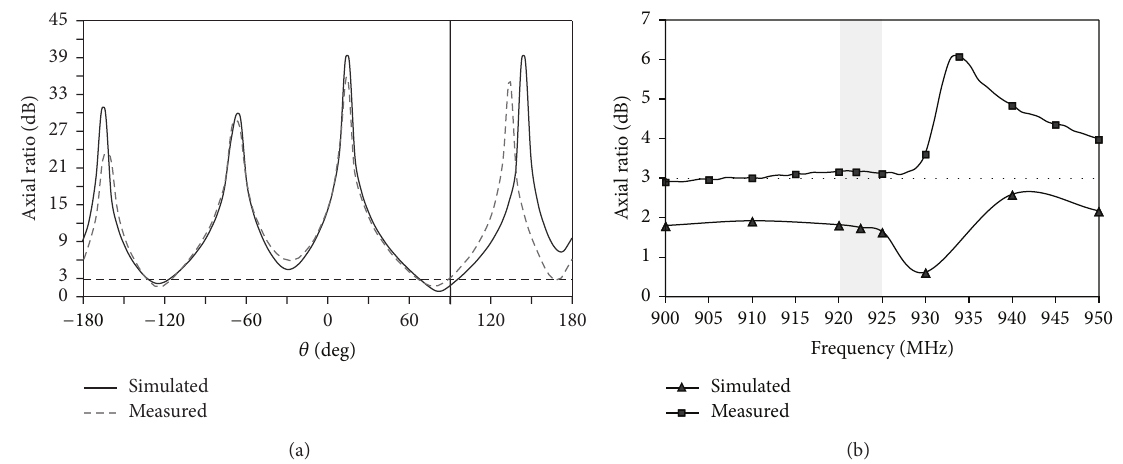
Figure 5: Simulated and measured AR pattern of the proposed antenna in y-z plane ( 𝜙 = 90 ∘ ) at 925 MHz (a) as a function of 𝜃 and (b) as a function of the frequency at 𝜃 = 90 ∘ .